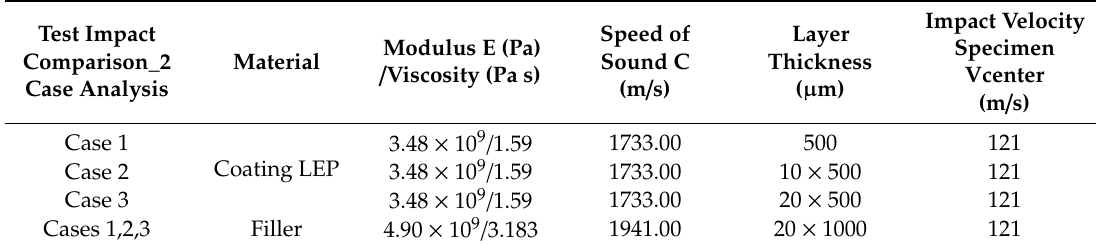
, in substrate C L . C L